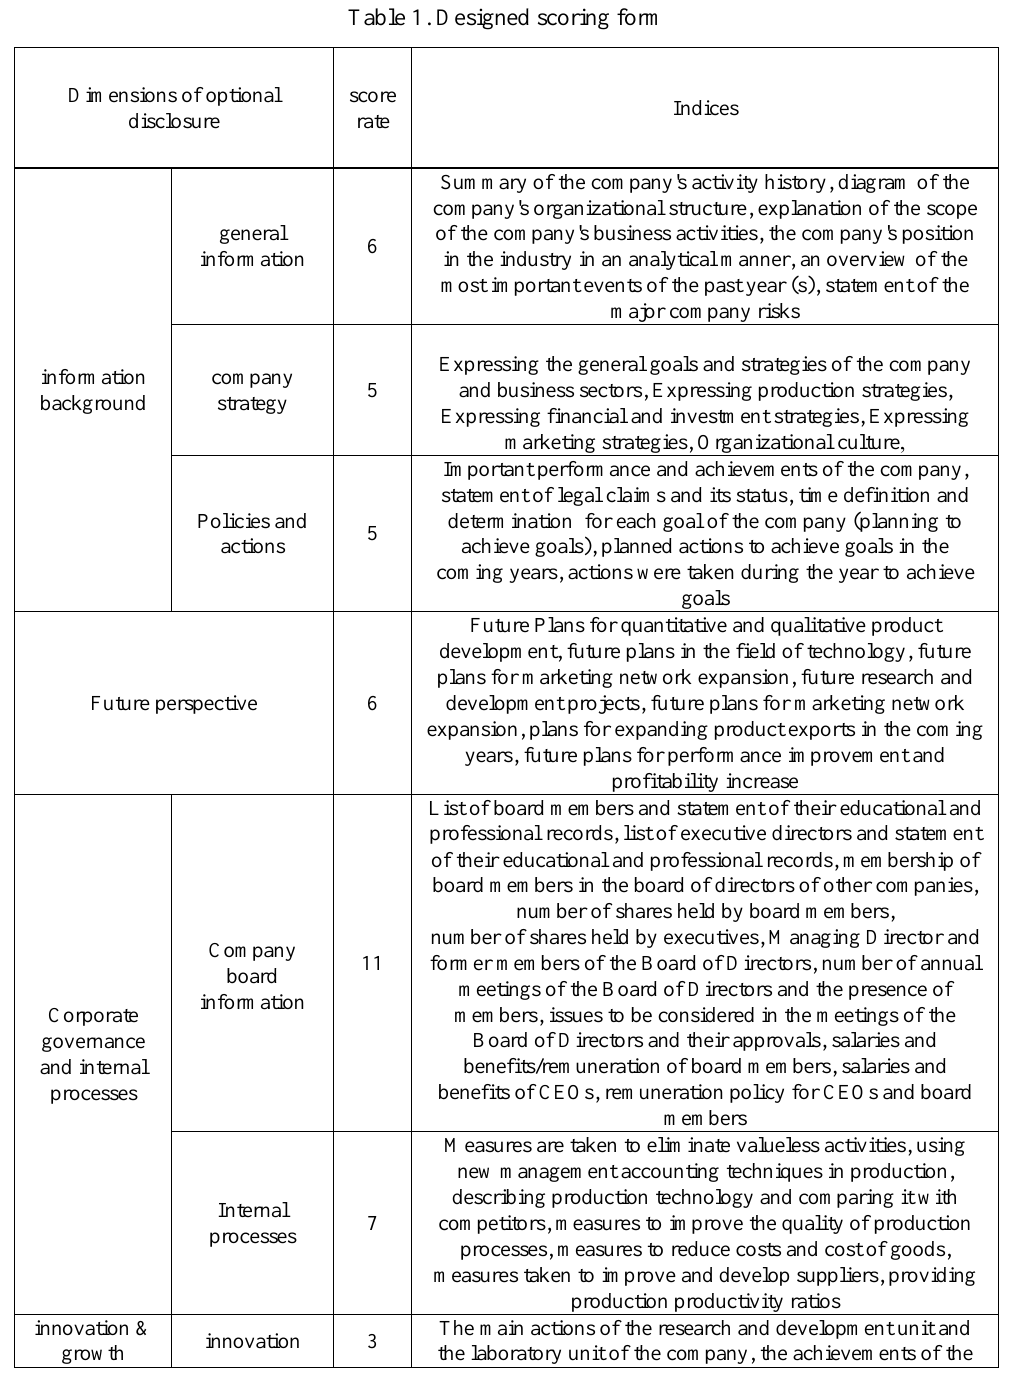
Table 1. Designed scoring